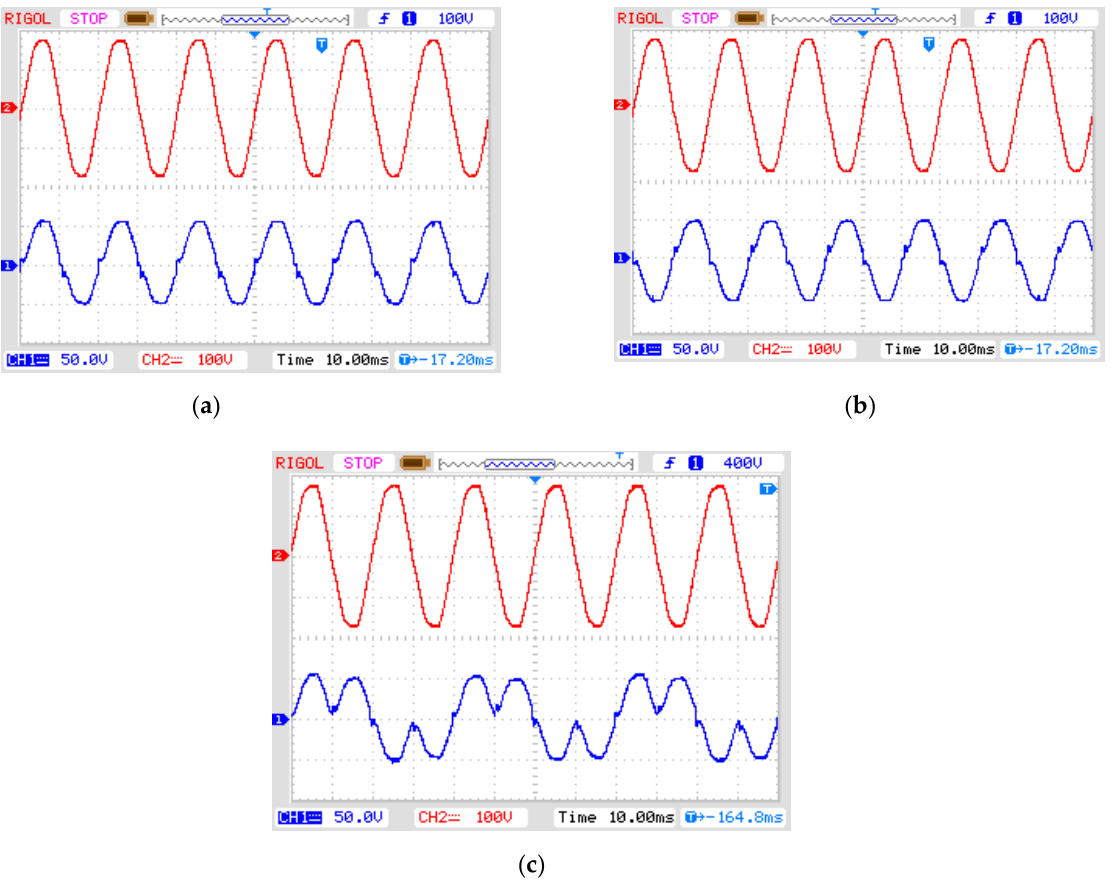
Figure 7. Recording of output waveforms (blue) with respect to input voltage (red) with a voltage gain of 0.3: ( a ) voltage in-phase form; ( b ) voltage out-of-phase form; ( c ) frequency regulation form.